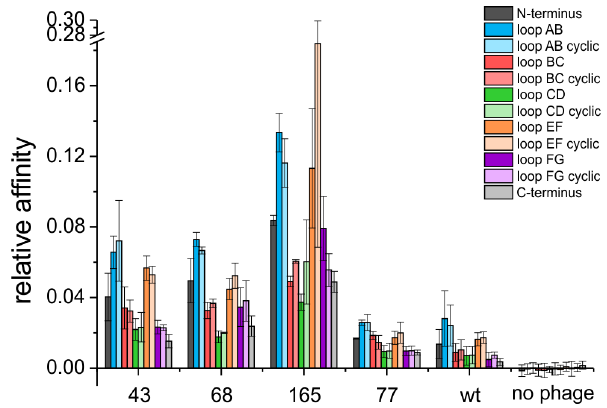
Figure 6. In vitro epitope mapping indicating binding of selected phage clones to extramembranous regions of bacte- riorhodopsin. Biotinylated peptides representing loops and termini of bacteriorhodopsin were immobilized on streptavidin coated plates. Peptides representing loops were provided in linear and cyclic conformation. Binding of selected phages to the peptides was quantified by antiphage ELISA. Normalized mean values from three independent experiments are shown. Numbers below the bars refer to the given ID numbers of each phage clone. Wild type (wt) phages without any peptide insert served as negative control. Peptides containing loop DE of bR were not included in the experiments, since cross-reactivity with the wild type phage was